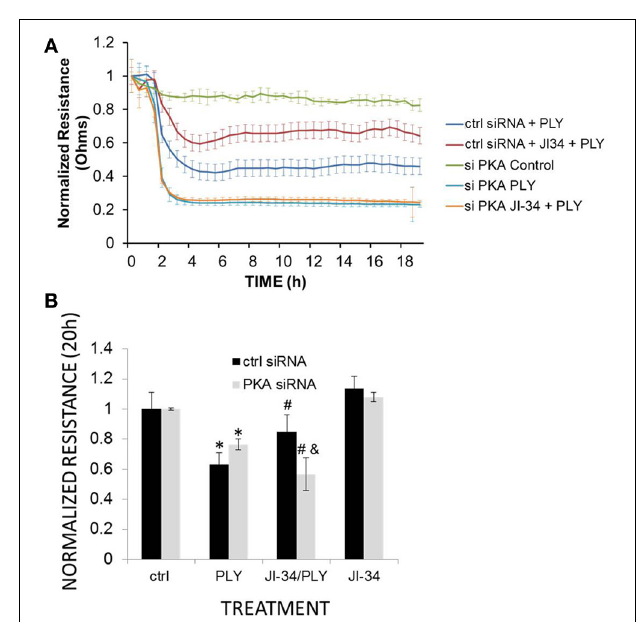
FIGURE 10 | (A) TER of HL-MVEC monolayers transfected with either scrambled (control) or PKA α cat. siRNA, that were treated with vehicle, JI-34 (1 μ M), PLY (30ng/ml), or JI-34 + PLY. N = 4 per group and data are depicted as mean ± SD . (B) TER at 20h of ctrl or PKA-depleted HL-MVEC treated with JI-34 (1 μ M), PLY (15ng/ml), or JI-34 + PLY. ∗ p < 0 . 05 vs. ctrl; # p < 0 . 05 vs. PLY in control siRNA-treated cells; # , & p < 0 . 05 vs. PLY in siRNA (PKA) transfected